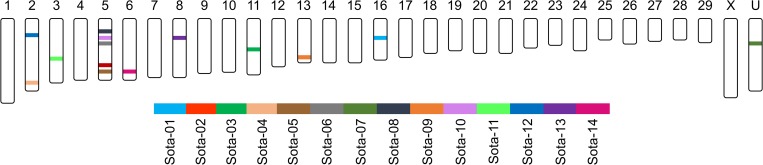
Provisional synteny map.For each Bos taurus chromosome, synteny segments for Tursiops truncatus are positionally indicated by colored bars. Bos taurus chromosomes are ordered by number. The U chromosome represents sequences that are unmapped to a particular chromosome.